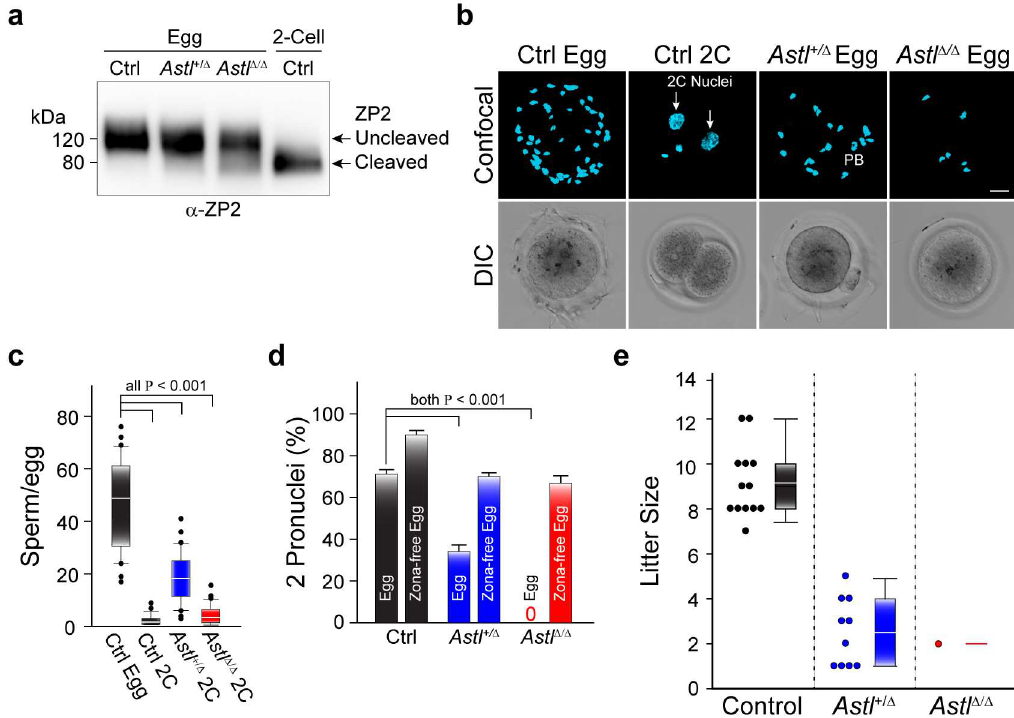
Fig 5. Prematurecleavageof ZP2 affects fertility of Astl mutant mice. (a) Immunoblotof zonaepellucidaefrom wild-type(Ctrl), Astl +/ Δ and Astl Δ / Δ ovulatedeggs as well as wild-type2C embryos (Ctrl) stainedwith a monoclonal antibody (M2c.2) that binds to the C-terminus of ZP2 and detected intact (upper arrow) and cleaved(lower arrow) protein. Molecularmass (kD) on left. (b) Sperm bindingto wild-typeeggs, 2C embryos, Astl +/ Δ and Astl Δ / Δ eggs. Confocalprojections(upper) and DIC (lower) images were obtainedafter fixation and stainingnuclei with Hoechst. Arrows, nuclei;PB, polar body. Scale bar, 20 μ m. (c) Average ( ± s.e.m) number of sperm bound to wild-typeeggs (Ctrl), 2C embryos (Ctrl), Astl +/ Δ and Astl Δ / Δ eggs imaged in (b) . N = 30 in each case. (d) In vitro fertilization with wild- type (left), Astl +/ Δ (center) and Astl Δ / Δ (right) eggs with and without zonae pellucidae.Fertilizationwas determined by the presenceof 2 pronuclei12 hr after insemination. (e) Dot density (left) and associatedbox plots (right) of litters from wild-type(Control), Astl +/ Δ and Astl Δ / Δ females co-cagedwith fertile male mice. The box includesthe mean (horizontal line) and data betweenthe 25 th and 75 th percentile.Error bars indicate the 90 th and 10 th percentiles and outliersare indicatedby dots. Statistical differences in c and d were determined by 2-tailedStudent’sT-test, P <